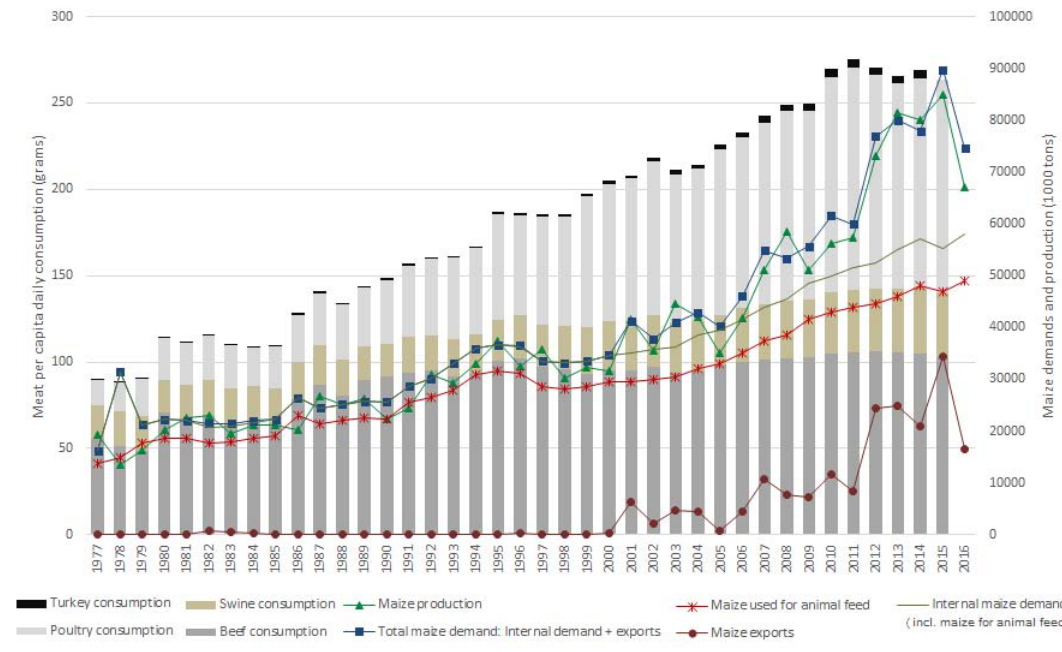
Figure 6. Brazilian national statistics for meat consumption and maize demand by the country’s internal demand and for exports (USDA, Supplementary Material